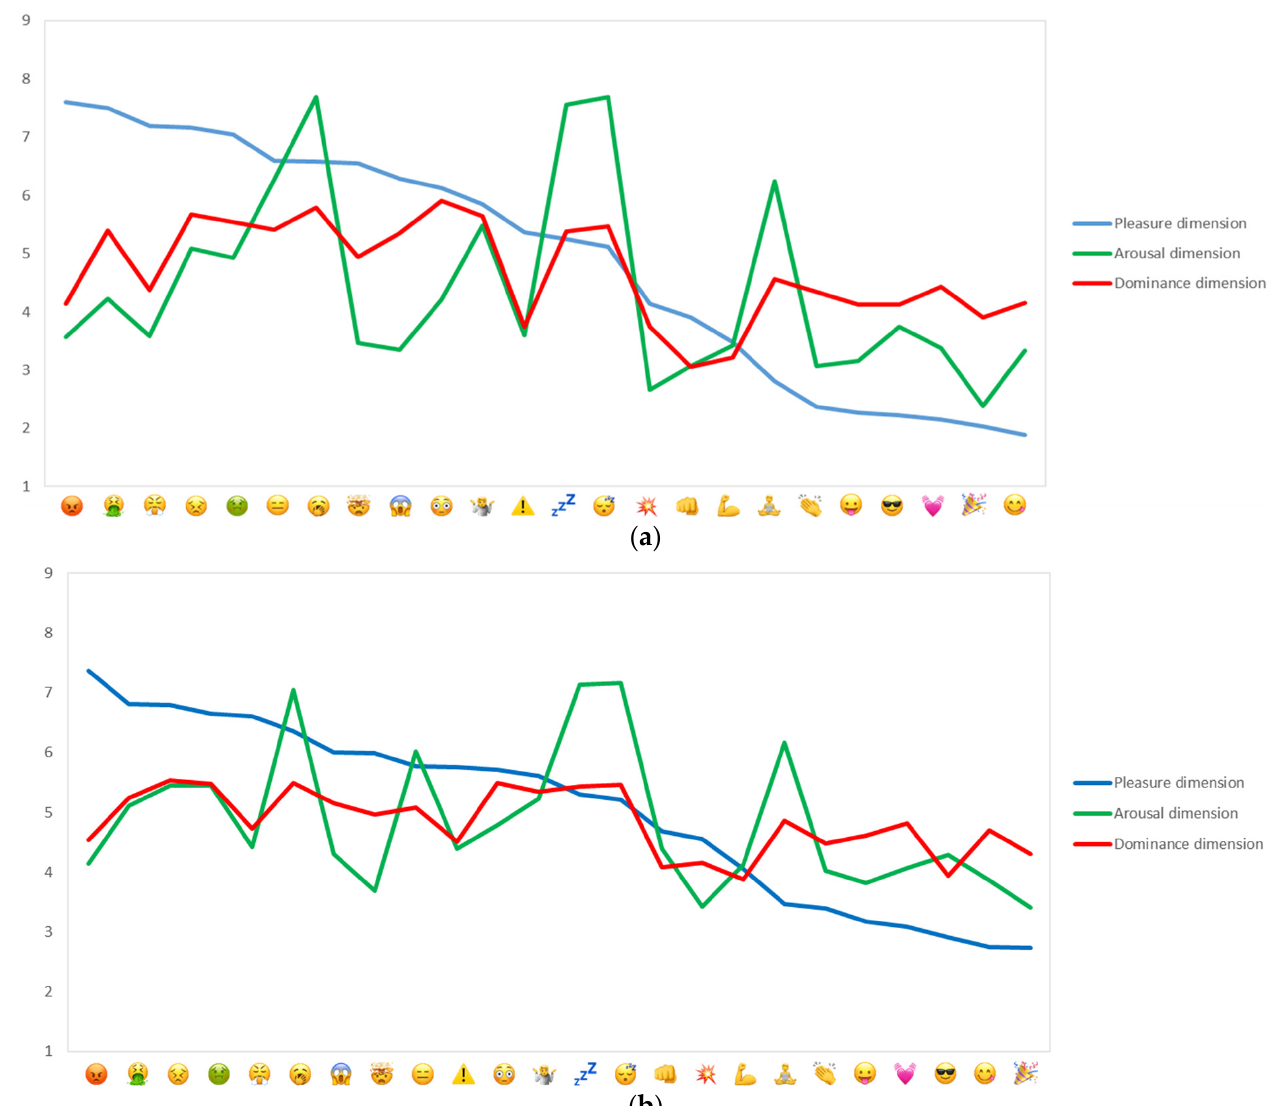
Figure 2. Emoji characterization by PAD dimensions for: ( a ) Study 1 (NZ) and ( b ) Study 2 (UK). Pleasure —low anchor (1) is associated with pleasure and high anchor (9) is associated with displeasure; Arousal —low anchor (1) is associated with arousal and high anchor (9) is associated with nonarousal (A); Dominance —low anchor (1) is associated with dominance and high anchor (9) is associated with submissiveness. Means are sorted by value for Pleasure within studies.